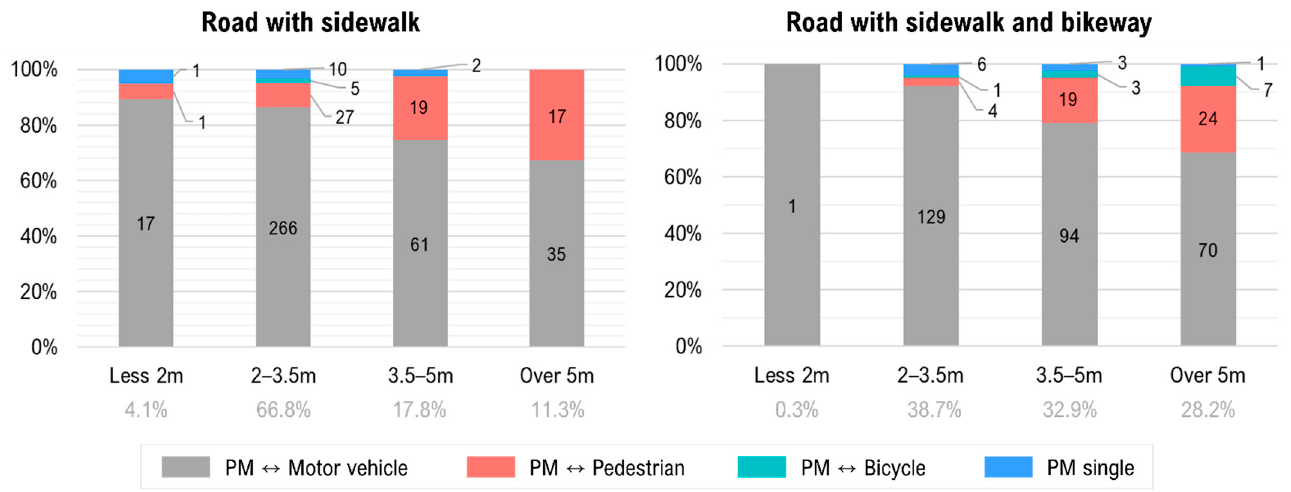
Figure 2. Accident frequency ratio of each accident type by sidewalk width .